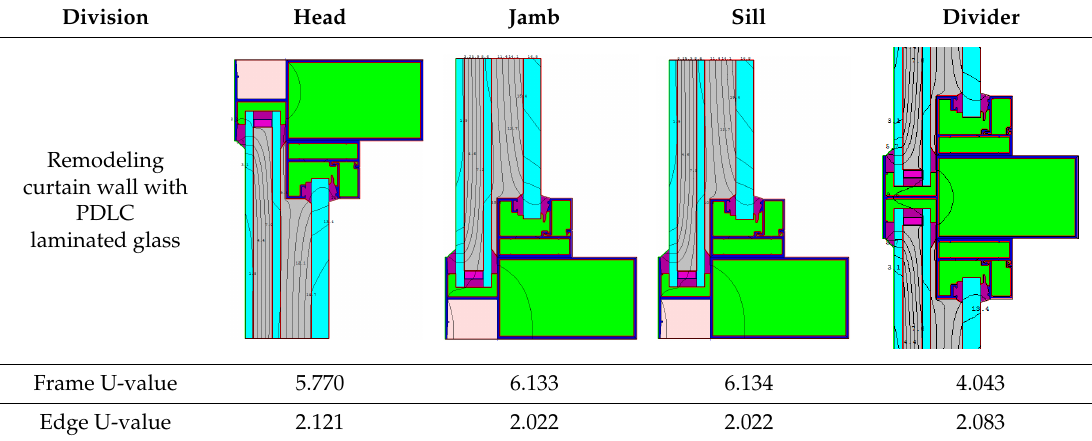
Table 10. Optical and thermal properties of the curtain wall system with PDLC window. Existing Division